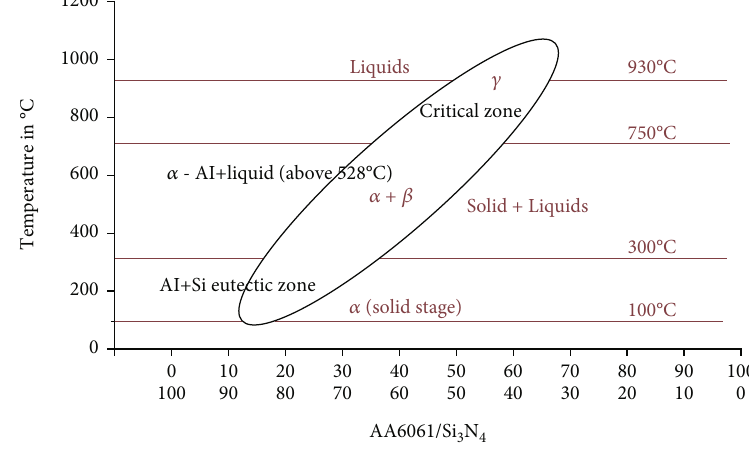
N nanocomposites with their various phase zone. 3 4